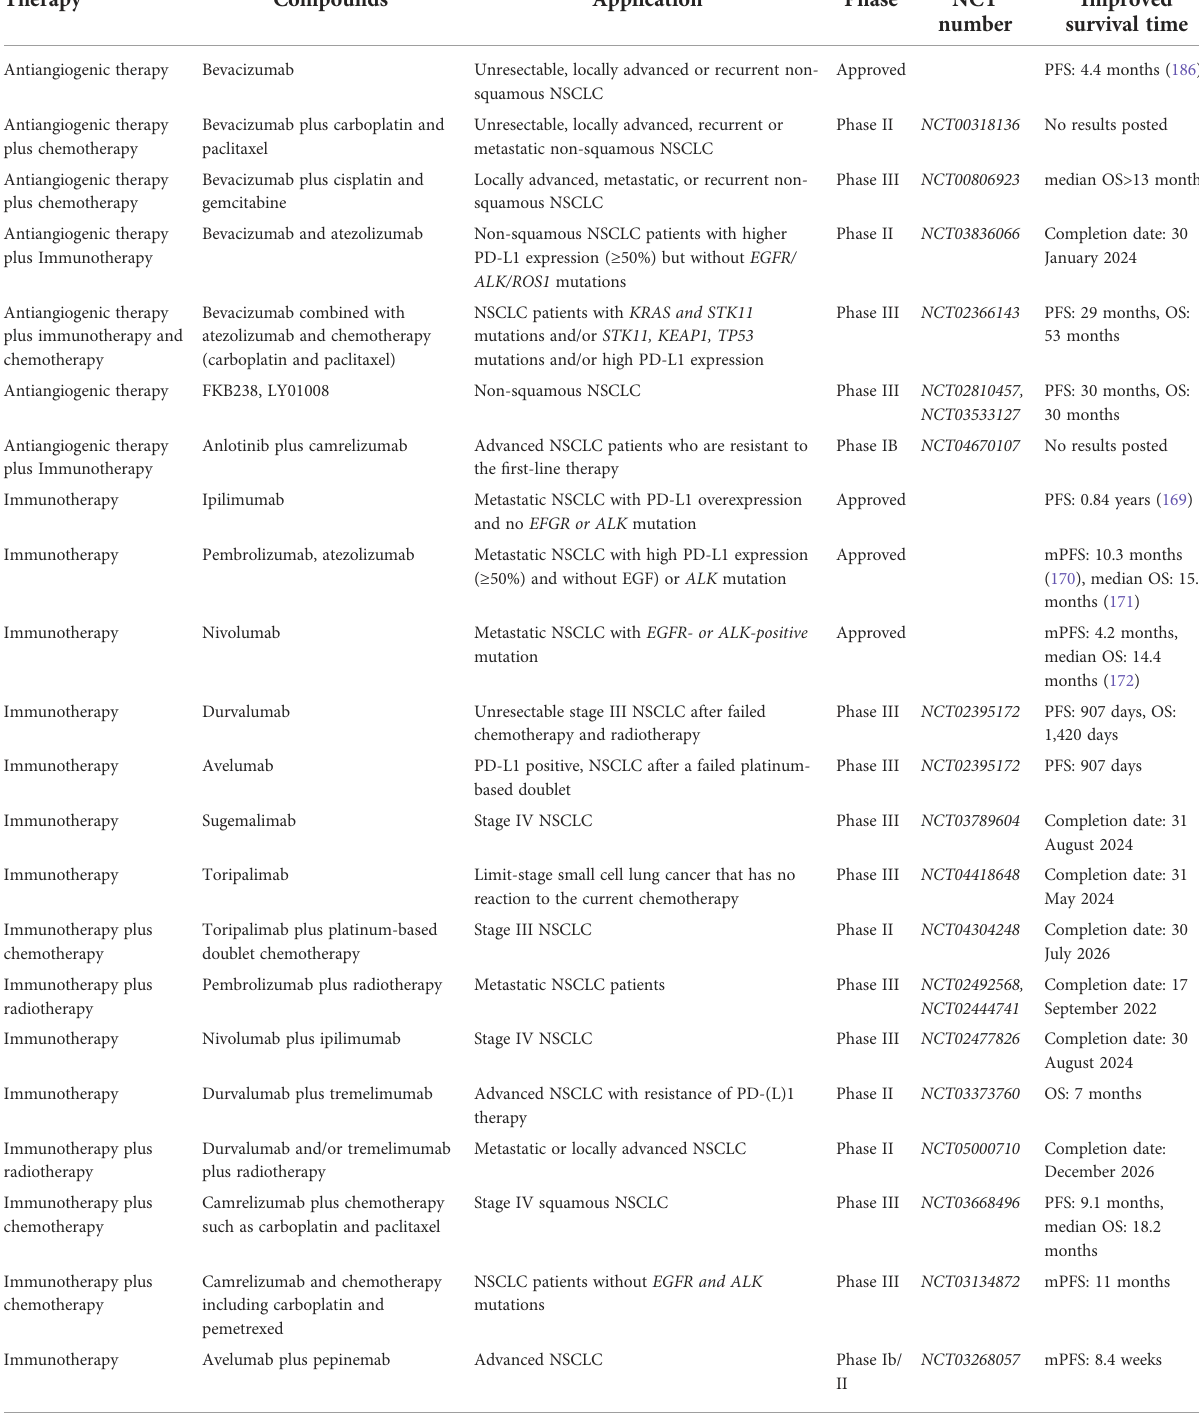
TABLE 3 Drugs used in antiangiogenic therapy and